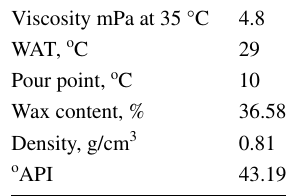
Fig. 2 Shear stress against shear strain rate for blank